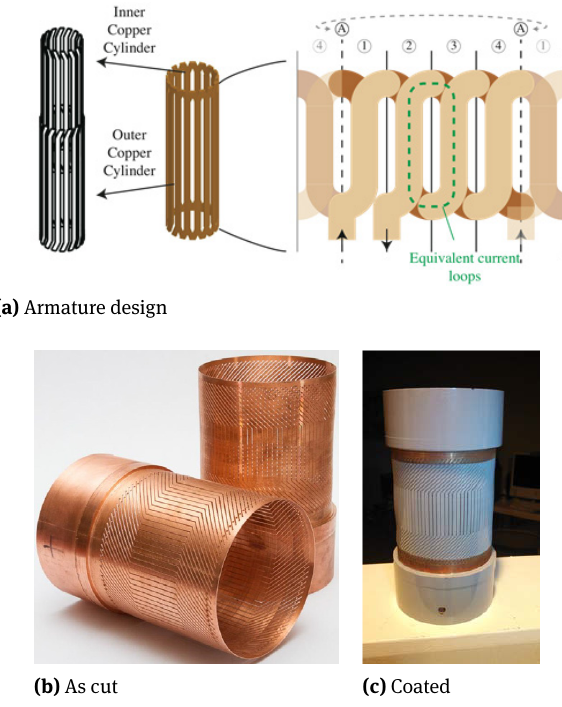
Figure 6: µ AWJ-machined slot-less armature